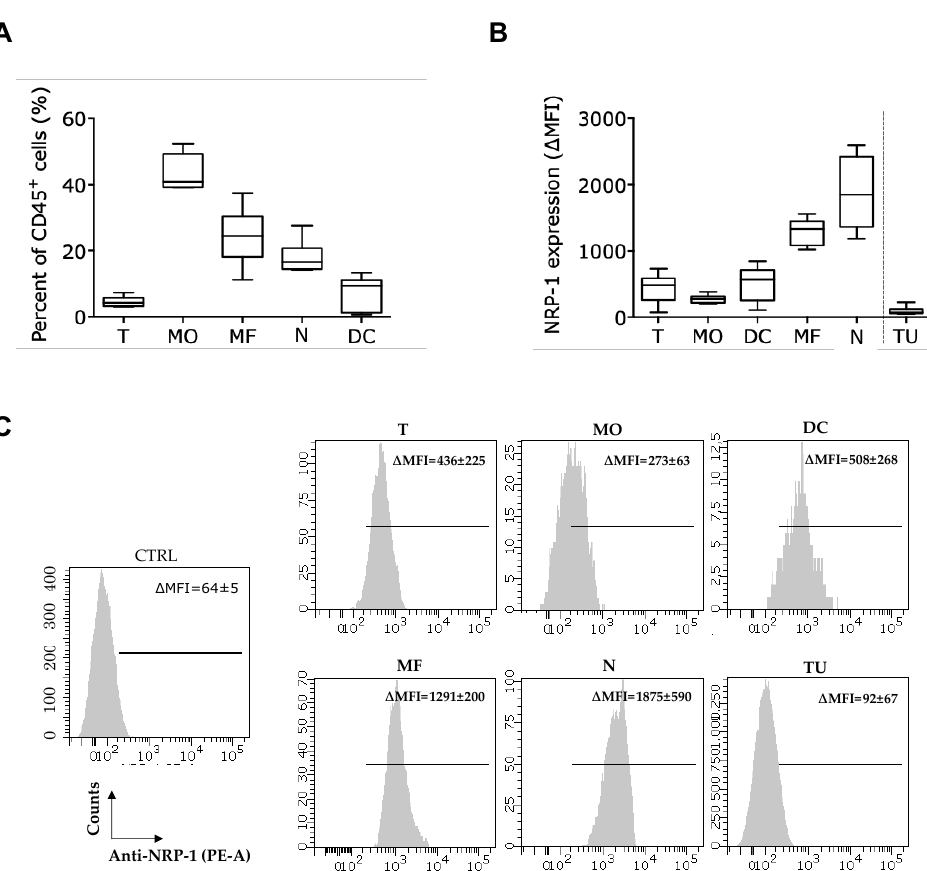
Figure 3. The colorectal carcinoma (CRC) model MC38 is characterized by a high infiltration with NRP-1 + tumor-infiltrating myeloid cells, while NRP-1 is expressed at low levels on cancer cells and T cells. ( A , B ) MC38 tumors were grown at the lower back of C57BL/6 mice up to a volume of 944 ± 237 mm 3 , after which tumors were isolated and reduced to single-cell suspensions. Expression of NRP-1 was evaluated on tumor-infiltrating immune cells and non-immune cells in flow cytometry. ( A ) The graph shows the percentage of T cells (T, CD45.2 + CD3 + ), monocytes (MO, CD45.2 + CD11b + CD11c − F4/80 − Ly6C + ), macrophages (MF, CD45.2 + CD11b + F4/80 + CD11c −/low Ly6C − ), neutrophils (N), CD45.2 + CD11b + Ly6G + ) and DCs (CD45.2 + CD11b - CD11c + ) that infiltrate MC38 tumors. The data are a summary of two independent experiments ( n = 2, mice per condition (mpc) = 3). ( B ) The graph and